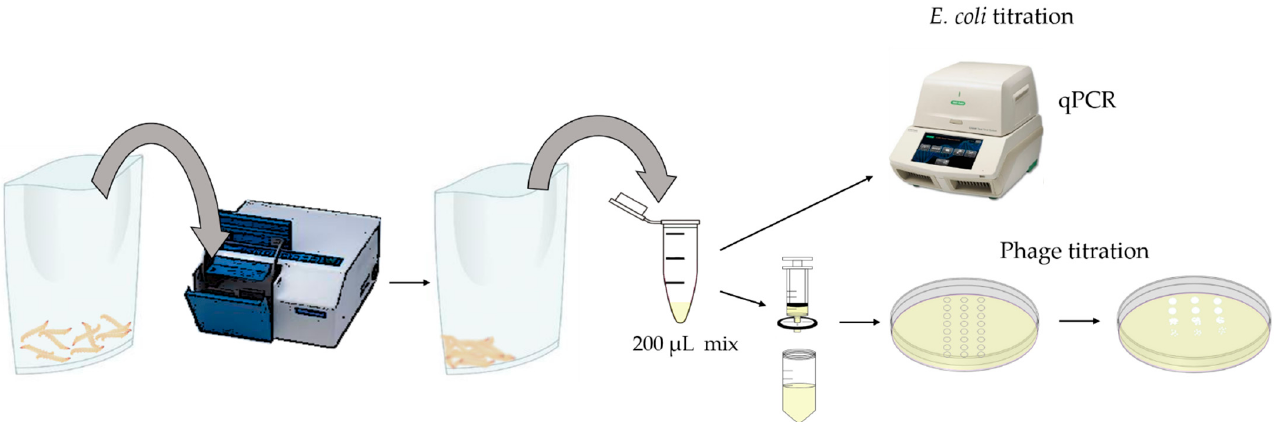
Figure 2. Representation of the titration process of bacteria and phages contained in the G. mellonella larvae.